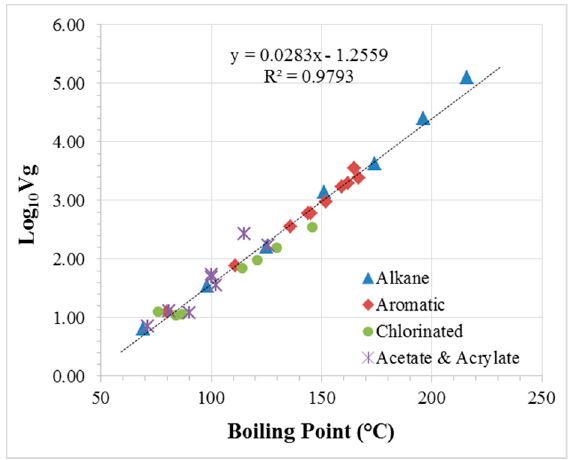
Figure 2. Relationship between Log 10 Vg and boiling points (°C). Note: Only applies to alkanes, aromatics, chlorinated compounds, acetates and acrylates.